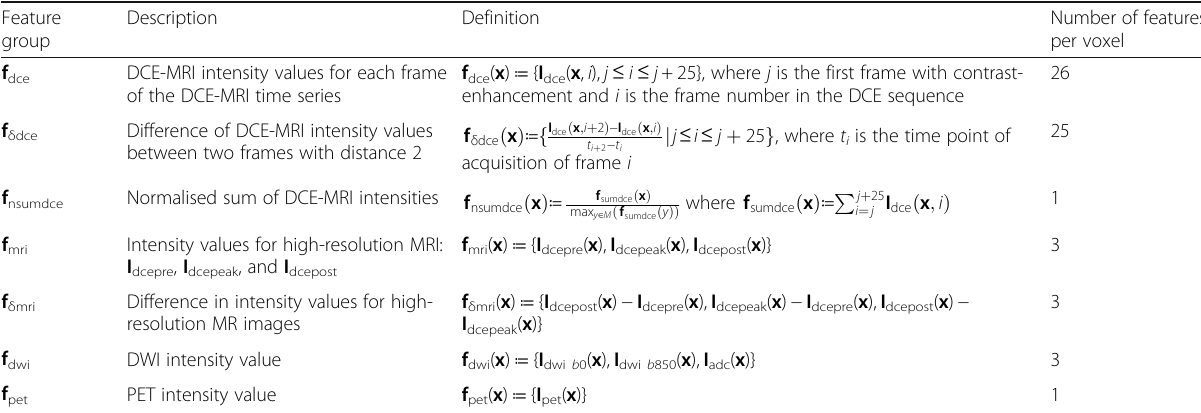
Table 2 Features extracted for each voxel ( x ) within the breast (M) Feature